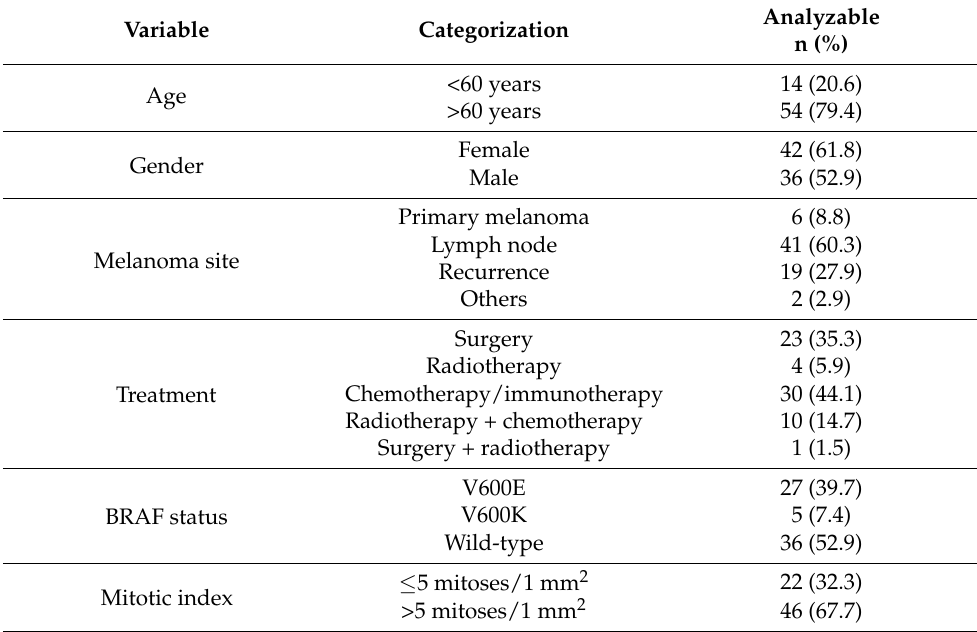
Table 1. Patients’